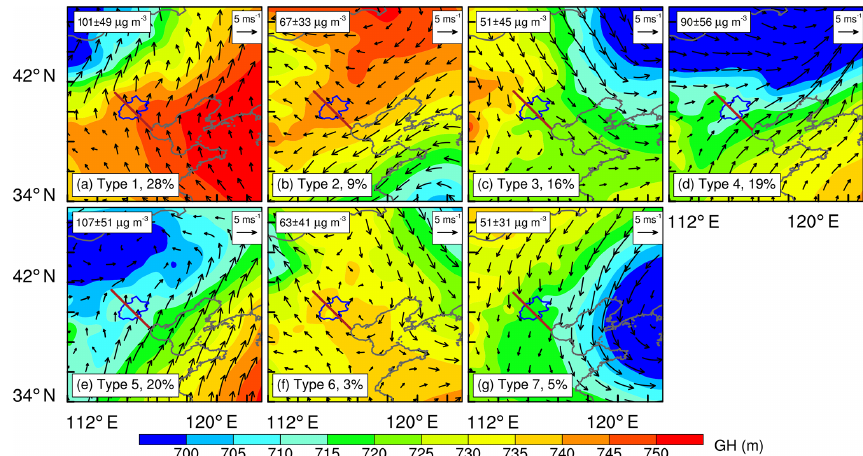
Figure 5. The 925hPa geopotential height (GH) fields (colored areas) and wind vector fields (arrows) in summer from 2011 to 2014 for the seven synoptic patterns: (a) Type 1, (b) Type 2, (c) Type 3, (d) Type 4, (e) Type 5, (f) Type 6, and (g) Type 7. The occurrence frequency of each synoptic pattern is given in the bottom left of each panel and the PM 2 . 5 concentration (the mean ± 1 standard deviation) is shown in the top left of each panel. The location of the Beijing metropolitan area is outlined in blue near the center of each panel. The red lines cutting through the Beijing metropolitan area in (a) – (g) indicate the location of the cross sections shown in Fig.